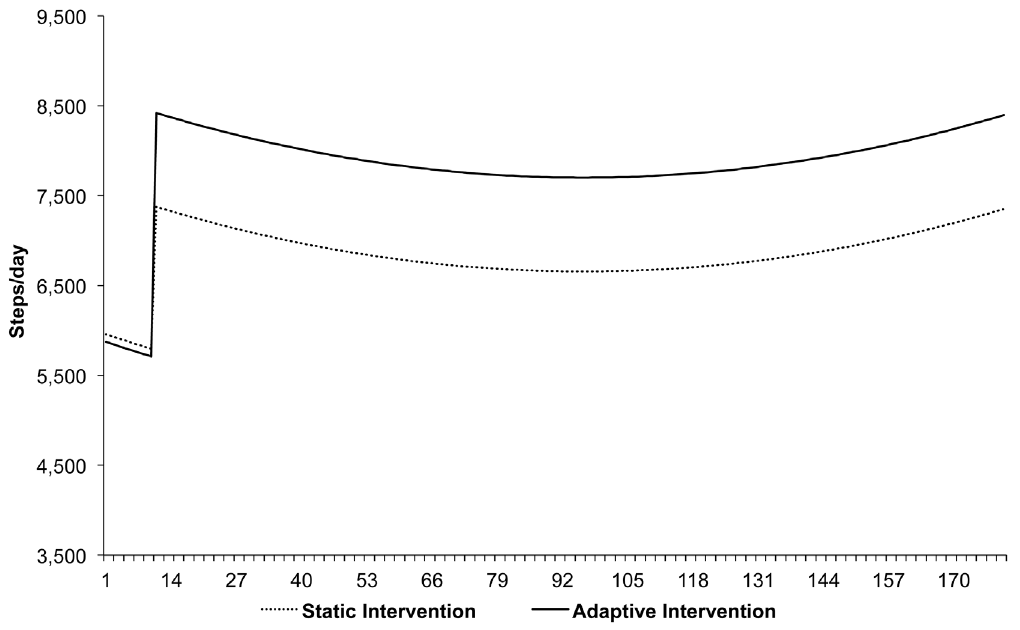
Figure 3. Prototypical trajectories a for Adaptive and Static Intervention groups based on mixed-effects repeated-measures model. a Prototypical trajectories for each group represent values for a 45-year old single women, non-white, with an income between $ 25,000– $